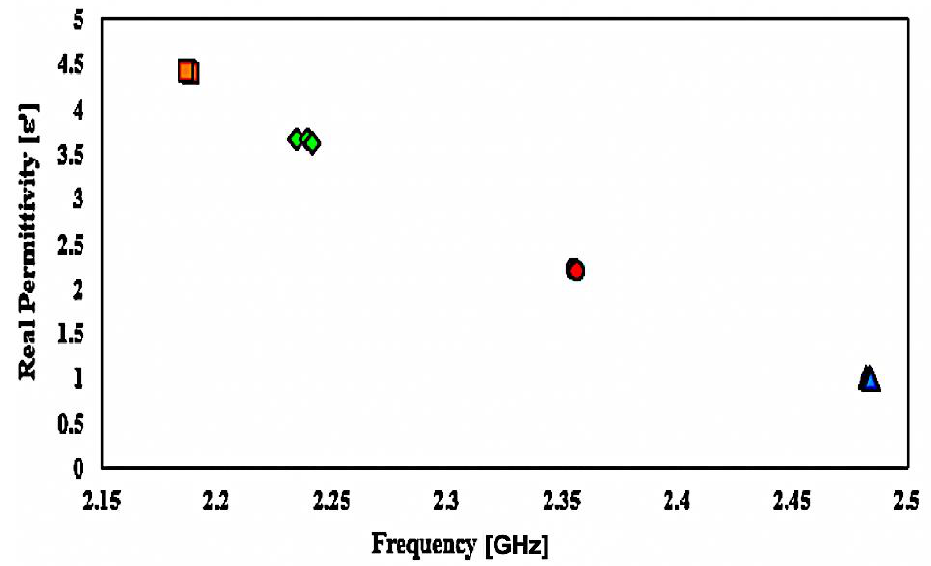
Figure 20. Repeatability measurement of curve-feed CSRR sensor for solid SUTs. Table 8 . Repetitiveness data in measuring the dielectric value of the SUTs .